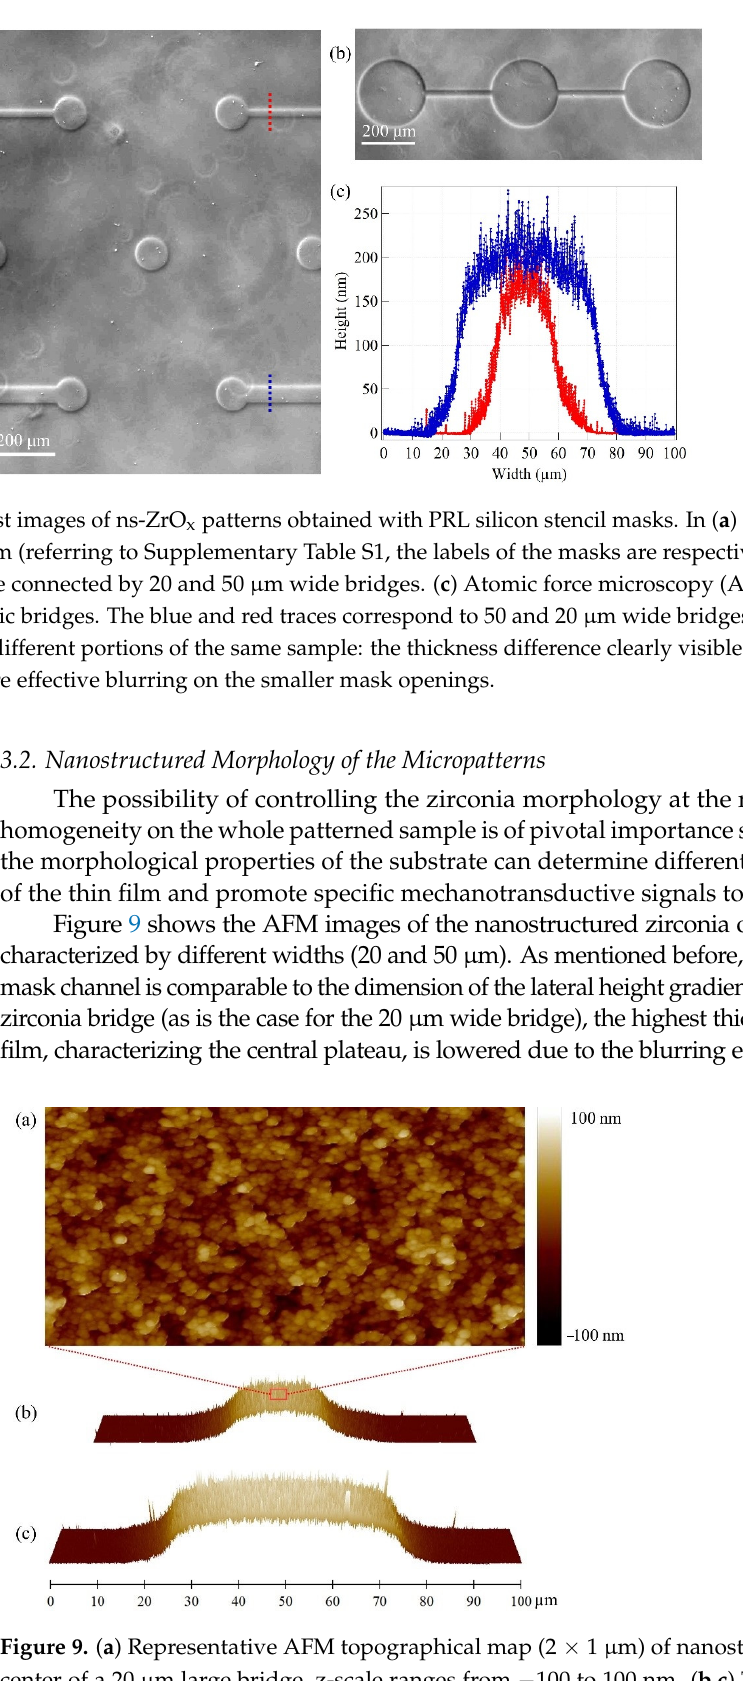
Table 1. Morphological properties of the nanostructured zirconia in different pattern features on the sample. Geometry of the Pattern